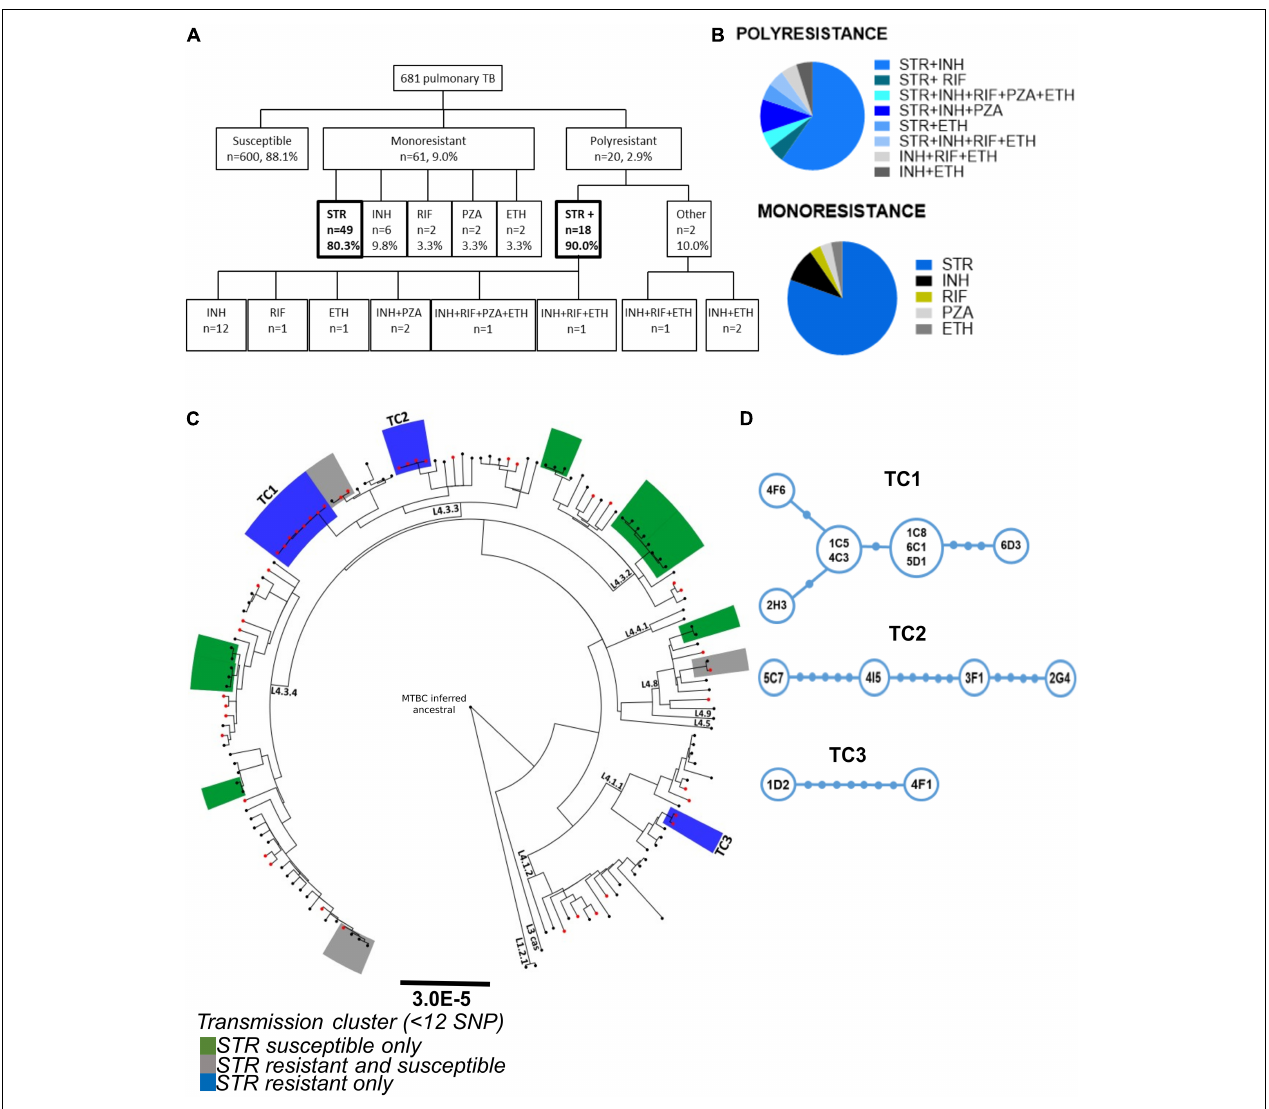
FIGURE 1 | Characterization of the prevalence and transmission of STR resistance in the study cohort. (A) Data from the drug susceptibility test of 681 pulmonary TB patients from the São João Hospital cohort (CHSJ). Susceptible refers to strains which displayed no growth in the drug-susceptibility test; monoresistance was defined as resistance exclusively to one of the anti-tuberculosis drugs tested; polyresistance corresponds to resistance to two or more anti-tuberculosis drugs, but not both isoniazid and rifampicin simultaneously; multidrug-resistance (MDR), resistance to isoniazid and rifampicin simultaneously, and/or other anti-TB drugs tested. Boxes in bold highlight the number/percentage of the monoresistant STR resistant isolates and of the polyresistance including STR resistance. STR+, resistance to streptomycin and other(s) anti-TB drug; Other, polyresistance which does not include the STR resistance. STR, streptomycin; INH, isoniazid; RIF, rifampicin; PZA, pyrazinamide; ETH, ethambutol. (B) Pie charts with the percentage of monoresistance and polyresistance of the cohort. (C) Phylogeny and transmission clusters of M. tuberculosis isolates from the CHSJ. Boxes highlighted in blue, green, and gray represent the transmission clusters. Blue, STR resistant isolates only (TC1, TC2, and TC3); green: represent clusters with STR susceptible isolates only and gray, with STR resistant and susceptible isolates. The black dots and red dots indicate the STR susceptible isolates and the STR resistant isolates, respectively. (D) Minimum Spanning Tree representation of transmission clusters, TC1, TC2, and TC3. Blue circles represent a node of M. tuberculosis isolates. The size of the circle is proportional to the number of strains represented. Filled blue circles in the connections indicate the number of SNPs between the